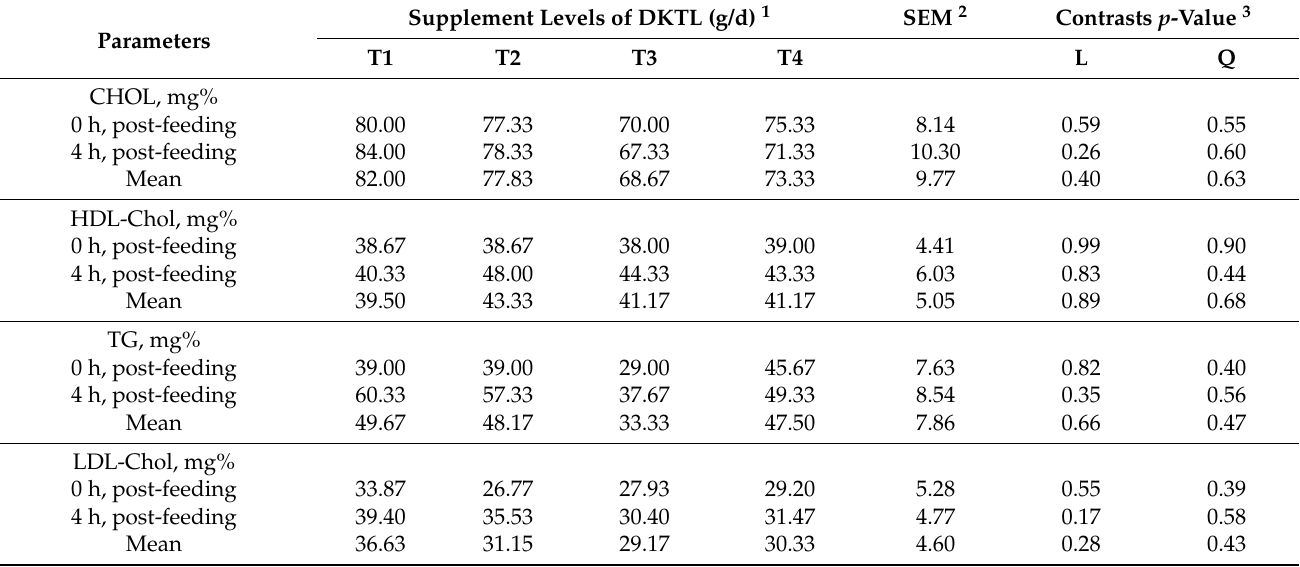
Table 10. Effects of Kratom leaves supplement on plasma parameters of fattening